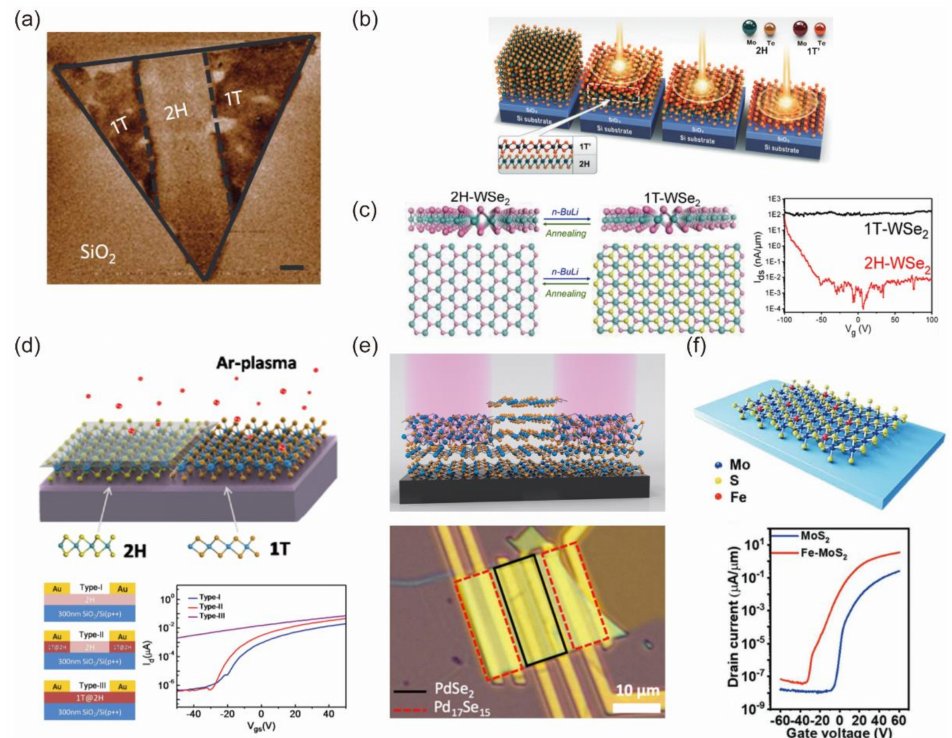
Figure 6. ( a ) Electrostatic force microscopy phase image of a monolayered MoS 2 nanosheet showing the difference between locally patterned 2H and 1T phase. Reprinted/adapted with permission from Ref. [68]. Copyright 2014, Springer Nature. ( b ) Schematic showing laser-irradiation-induced phase transition from 2H to 1T’ Phase in MoTe 2 . Reprinted/adapted with permission from Ref.